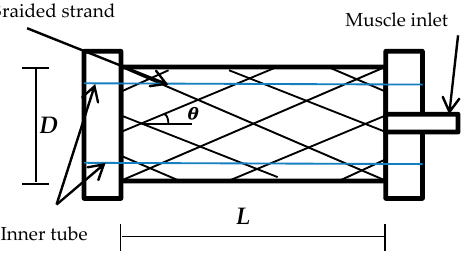
Figure 1. The structure of the pneumatic muscle actuator.